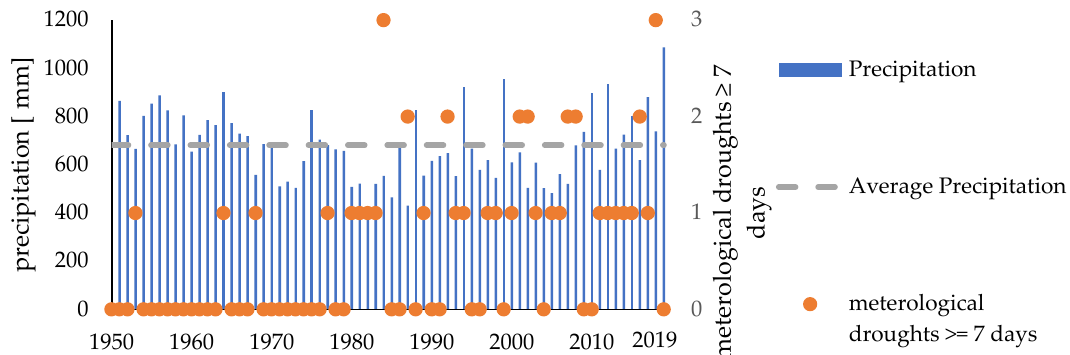
Figure 1. Annual Historic Precipitation at Ségou from 1950 to 2019. Quantity of short droughts ≥ 7 days (orange dots) on the right scale. Data Provided by Vaksmann, IER [22].